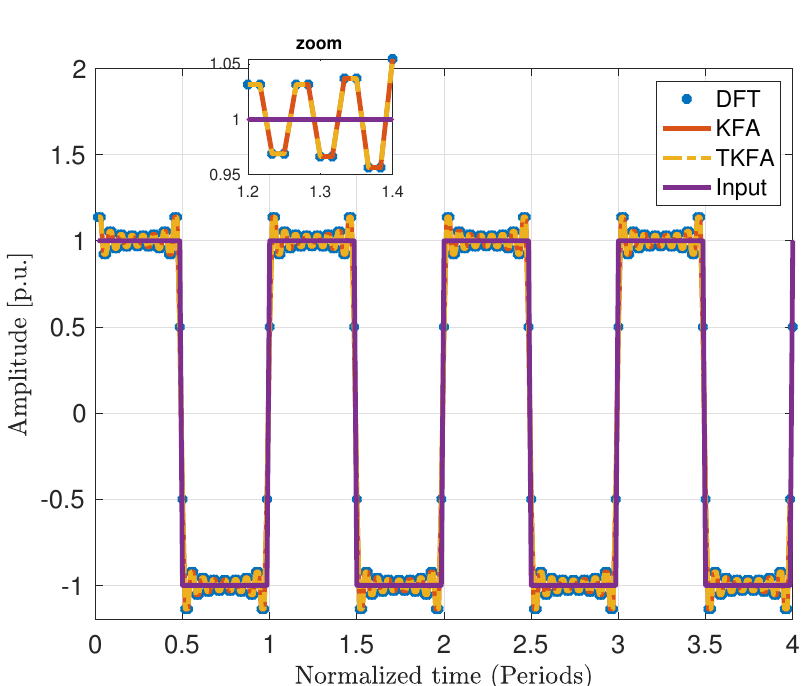
Figure 2. Reconstruction signal with DFT, KFA, and TKFA algorithms. The model considers 15 harmonic